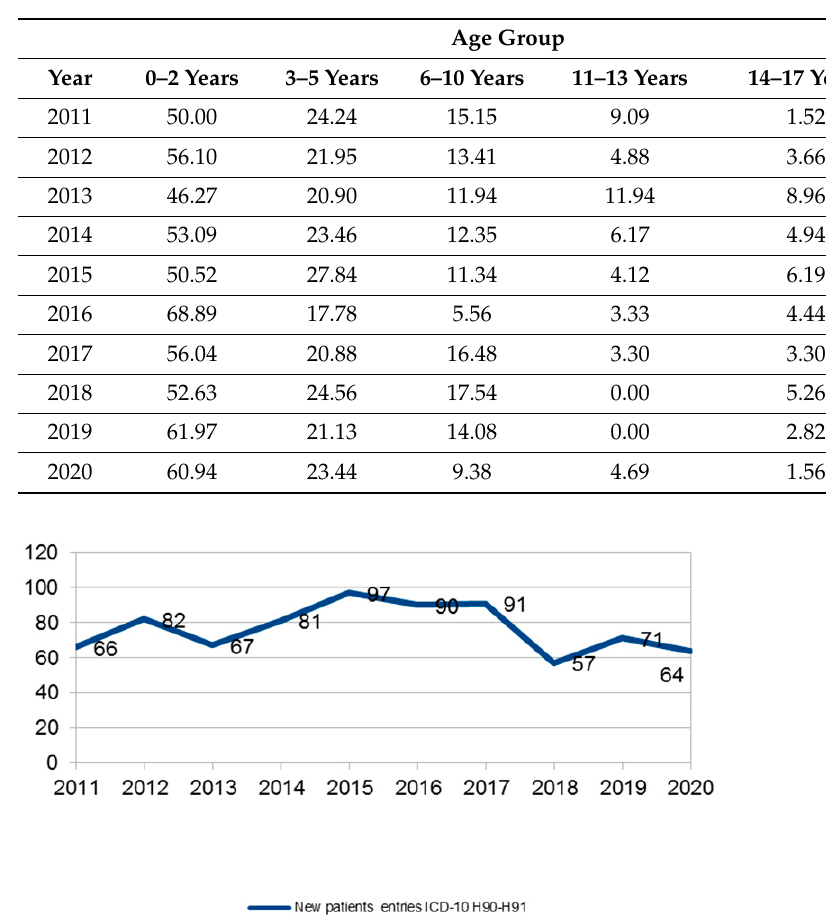
Table 2. Incidence of hearing loss by age in percentage.